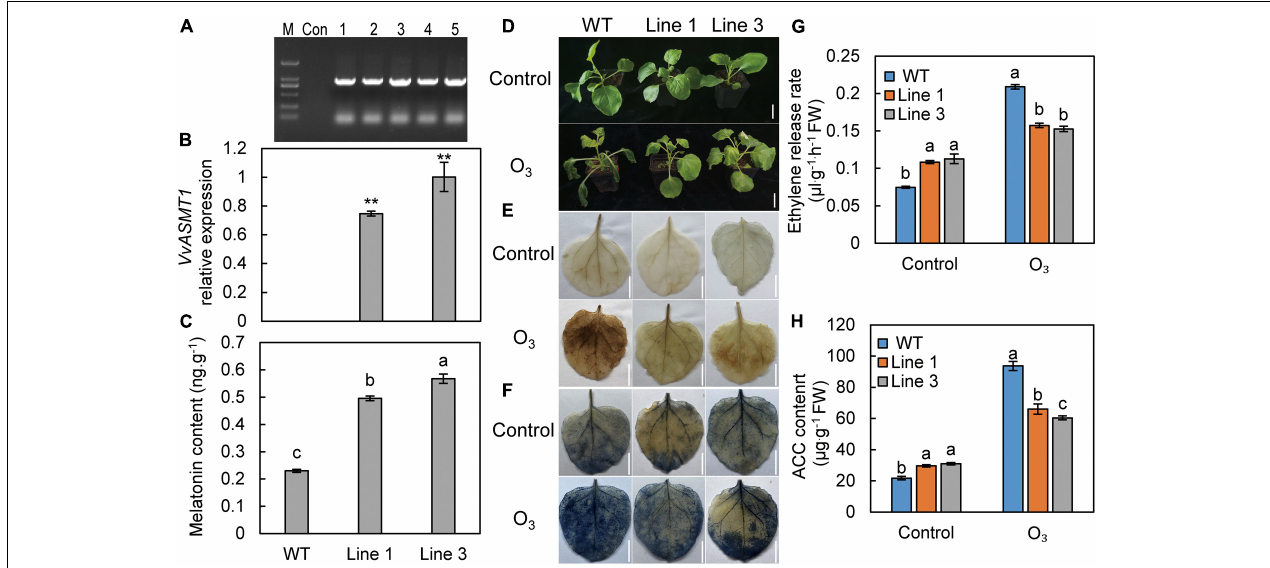
FIGURE 6 | Tobacco plants overexpressing VvASMT1 showed increased tolerance to O 3 . (A) PCR detection of VvASMT1 overexpression in tobacco. (B) The expression level of VvASMT1 in transgenic and wild-type tobacco. (C) The content of MT in transgenic and wild-type tobacco. Phenotypes (D) , H 2 O 2 staining (E) , O 2 − staining (F) , ethylene release rate (G) , and ACC content (H) of wild-type and transgenic lines after O 3 treatment. The numbers 1–5 represent five different tobacco lines; M, DNA marker; Con, control; ASMT , acetylserotonin methyltransferase ; WT, wild-type. Values represent the means ± SD of three replicates. **Highly significant difference, P < 0.01. Values indicated by the same lowercase letters are not significant at P < 0.05. Bars, 3 cm in (D) , 2 cm in (E,F) .